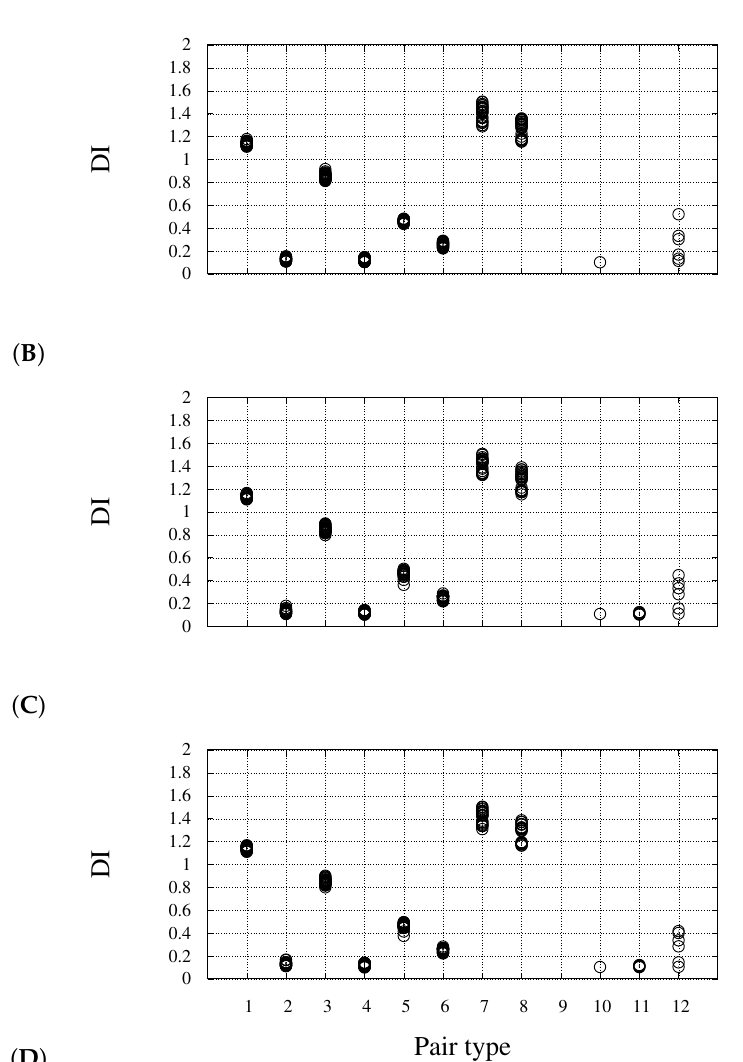
Figure 8. DI ( y axis) for different atom pairs (see list below and Figure 2) along with the approach of Na towards the molecule: ( A ) initial configuration (conf. 30 in Figure 6); ( B ) first-encounter configuration (conf. 100 in Figure 6); ( C ) minimal energy configuration (conf. 148 in Figure 6); ( D ) settled configuration (conf. 150 in Figures 6 and 7). List of atom pairs: 1—Pt1-Ct;